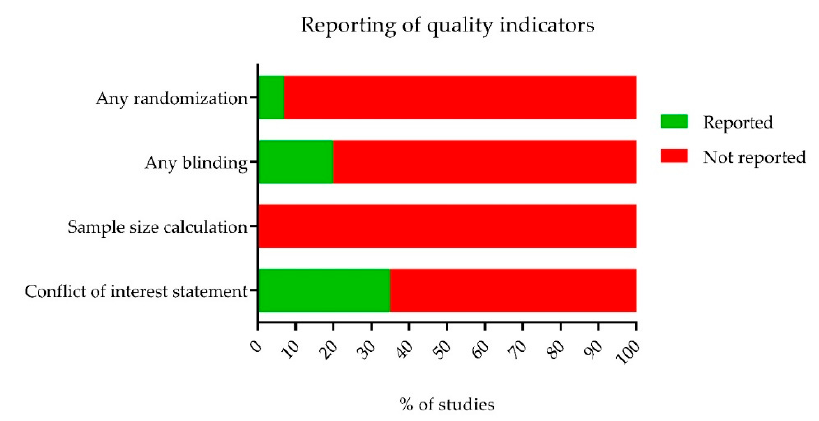
Figure 3. Reporting of four quality indicators in the 124 included studies. Only 7% of studies reported the use of any form of randomization, 20% reported the use of blinding and not one study reported a sample size calculation. In addition, only 35% of the studies reported a conflict of interest statement.